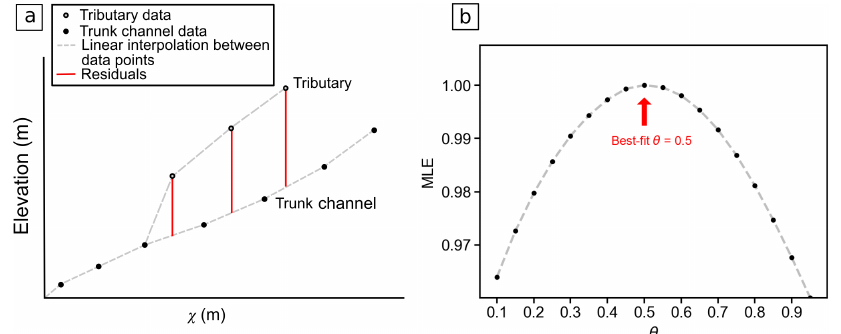
Figure 3. Sketch illustrating the methodology of the χ method using all profile data. In panel (a) , the χ profiles of both the trunk channel and a tributary are shown. We take the χ coordinate of the nodes on the tributary channel and then project them onto a linear fit of the trunk channel to determine the residuals between tributary and trunk channel. We do this for all nodes and for all concavity indices. For each concavity index, the residuals are then used to calculate a maximum likelihood estimator (MLE), which varies as a function of the concavity index (panel b ). The highest value of MLE is used to select the likely θ